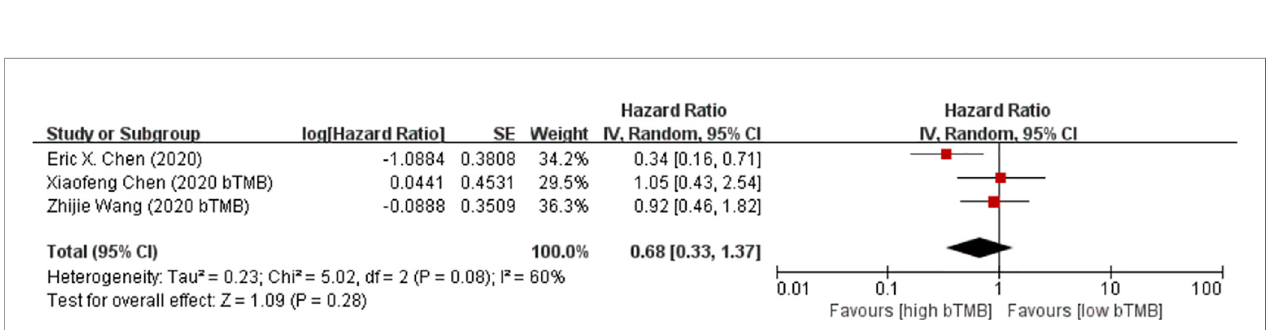
FIGURE 7 | Forest plot of the random effects meta-analysis on the ef fi cacy of blood tumor mutation burden (bTMB) for overall survival